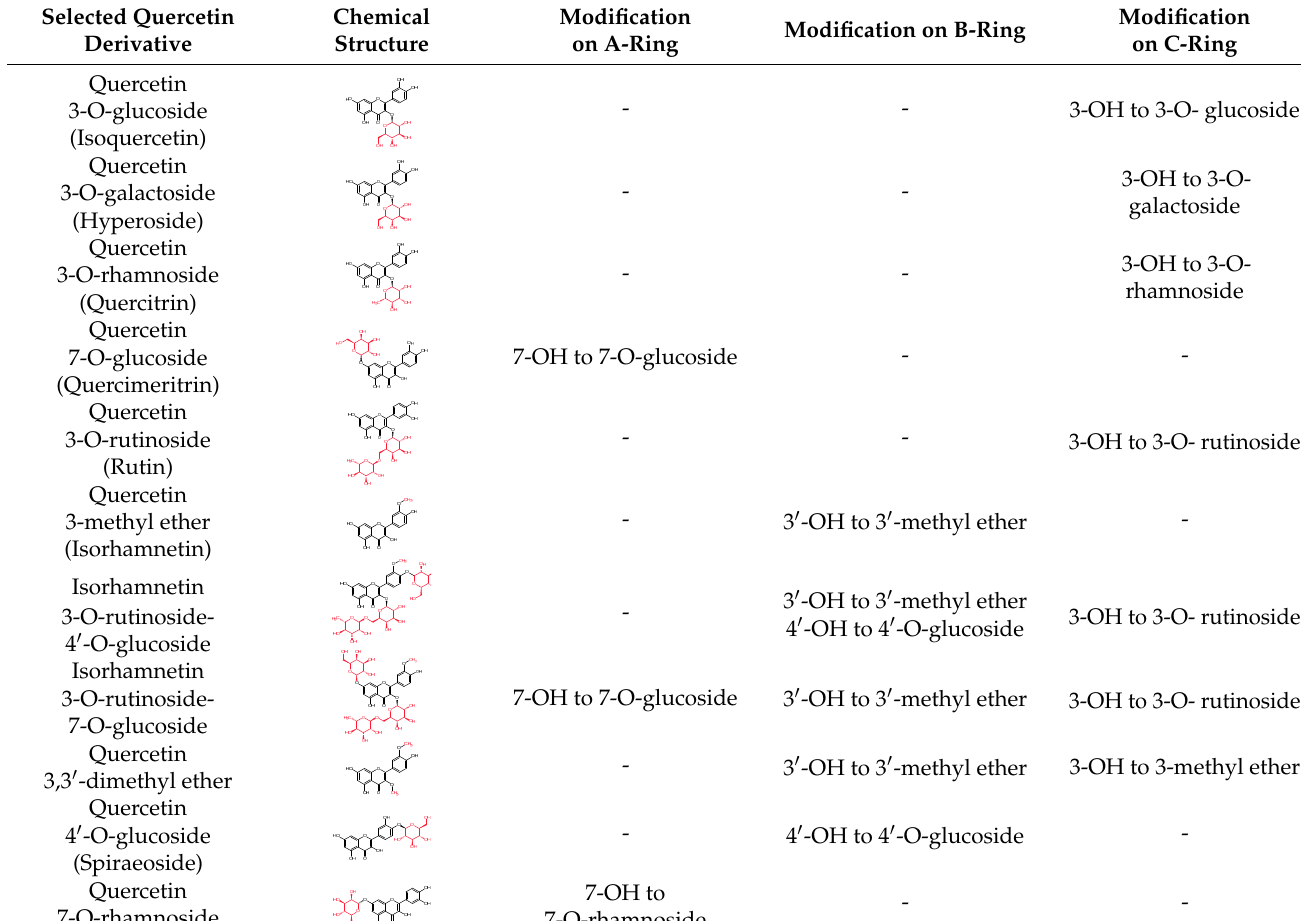
Table 2. Selected quercetin derivatives alongside the position of the modification (see Figure 1 for correspondent numbers of the carbon atoms).